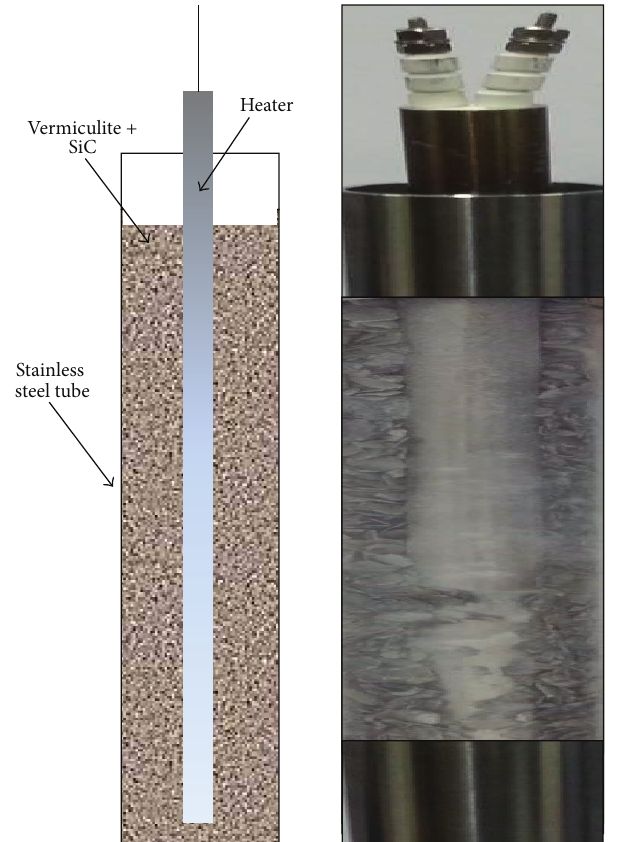
Figure 2: Stainless steel tube filled with vermiculate, silicon carbide (SiC), and